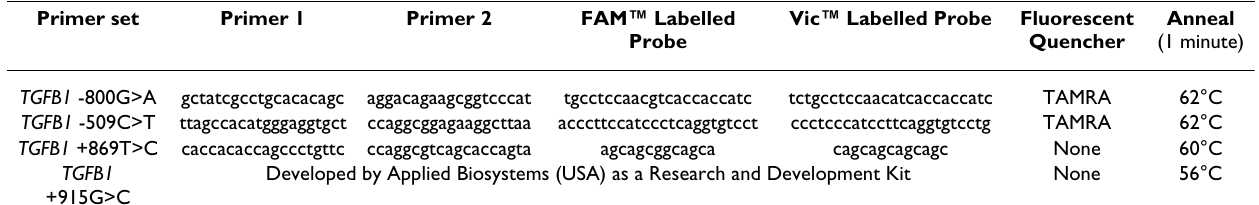
Table 4: TaqMan primers, probes, quencher and annealing temperature for relevant assays. Primer set